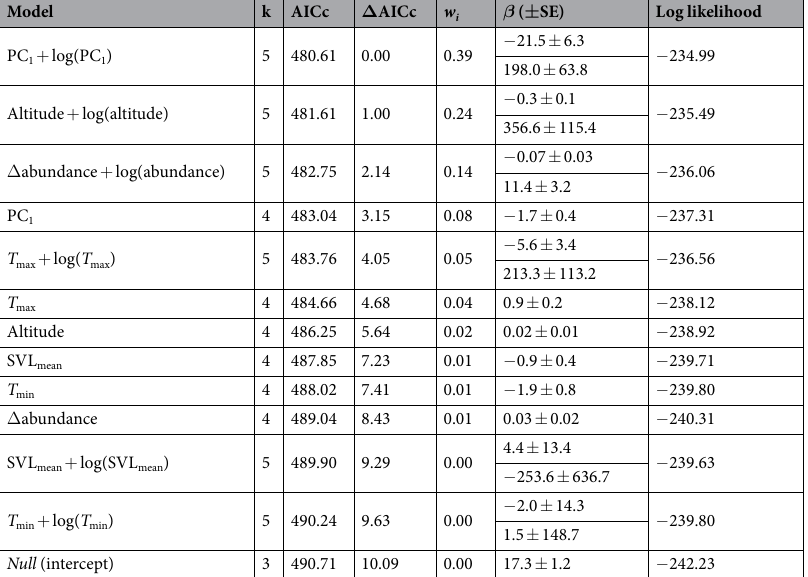
Table 1. AICc based model selection comparing a null model (intercept only) to models testing linear and non-linear (logarithmic) relationships between telomere length and computed environmental and individual variables (PC 1 – first axis of a principal component analyse including relative change in abundance, T min , and altitude) on telomere length in yearling common lizards ( n = 100). In models, the relative change in abundance and PC 1 were added a constant to enable log transformation. Population was treated as a random factor in all models to account for intra-population variation and non-independence. k: number of parameters, Δ AICc: difference with AICc of the best model, w i : model